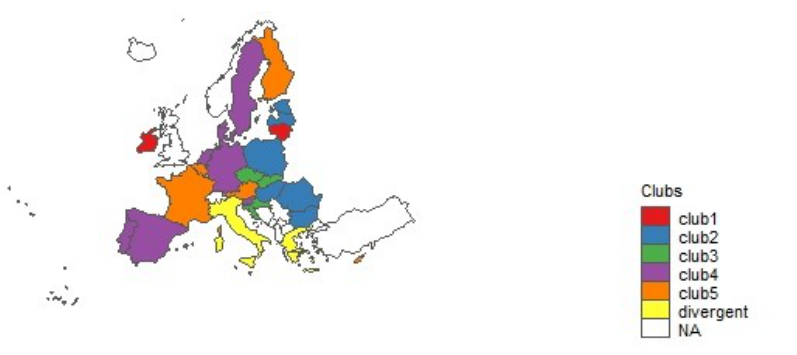
Figure 1. Convergence